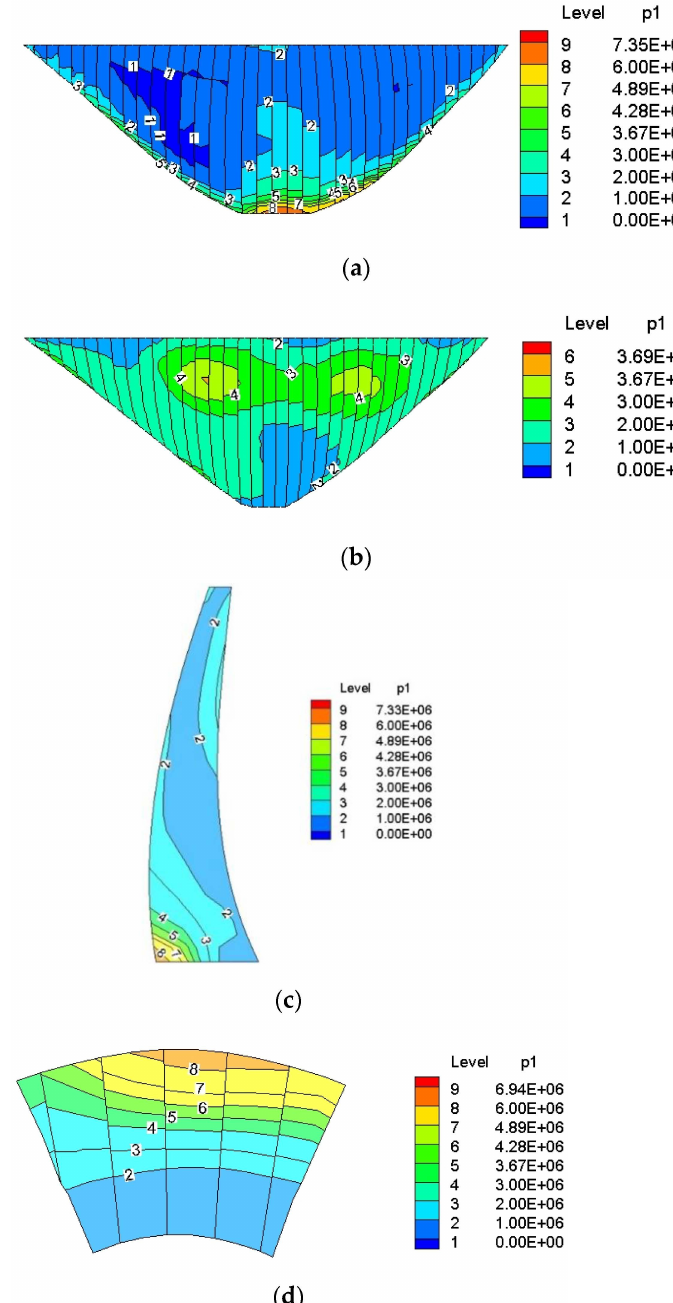
Figure 4. Envelopes of maximum tensile principal stresses using the new standard (Pa). ( a ) Up- stream surface, ( b ) downstream surface, ( c ) section of arch crown beam, and ( d ) arch section at dam bottom